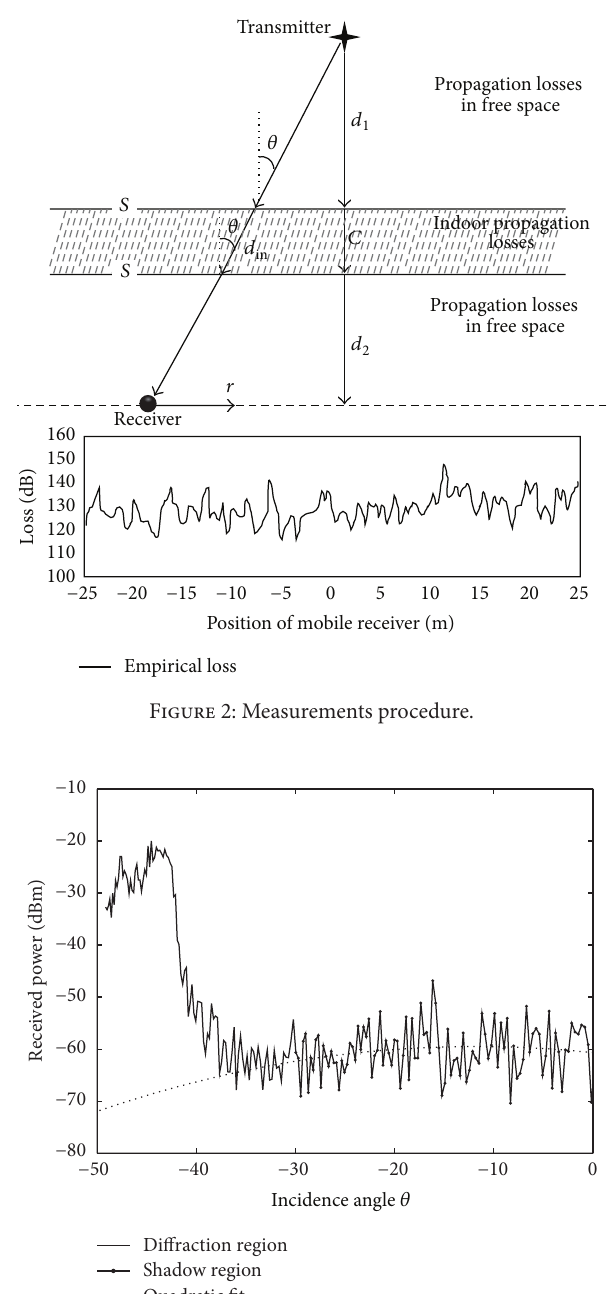
Figure 3: Received power versus incidence angle of building 3.